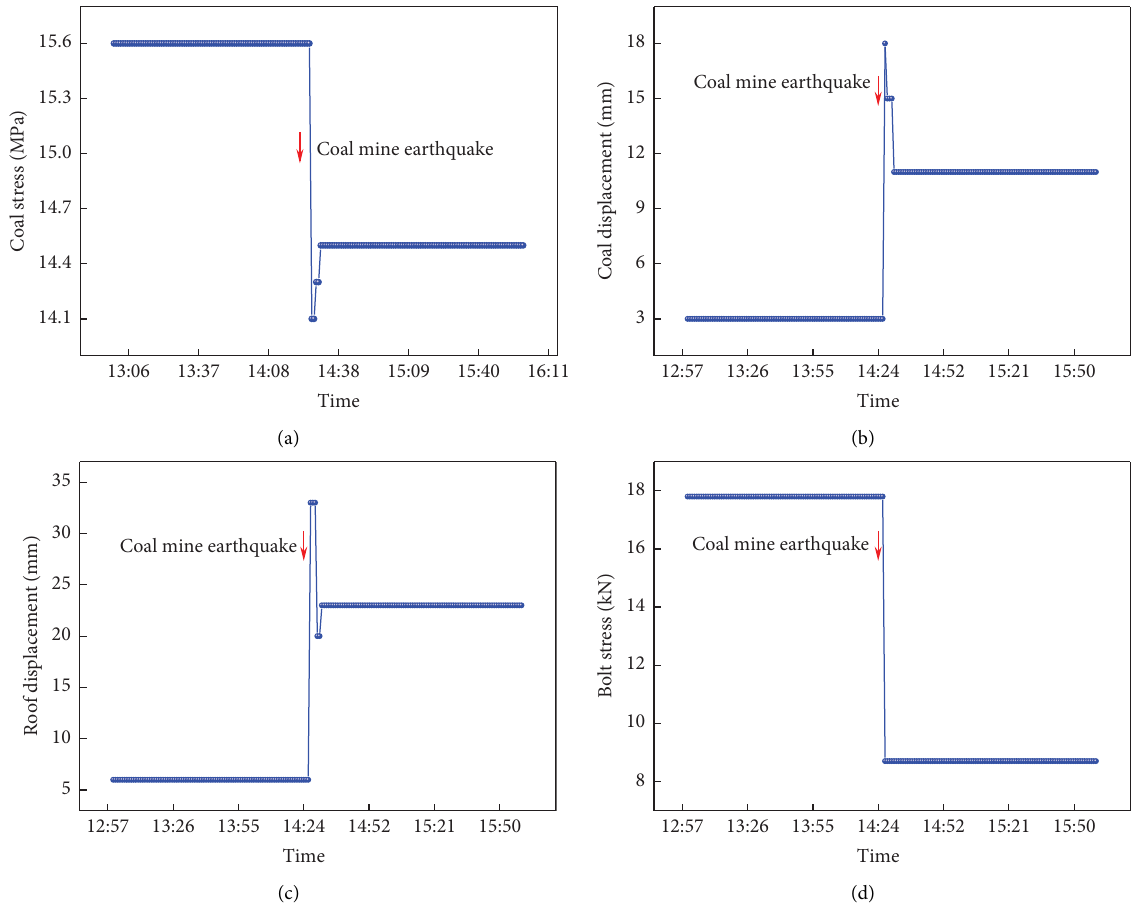
Figure 7: Parametric response curves during the coal mine earthquake. (a) Stress response curve of coal seam. (b) Displacement response curve of coal seam. (c) Roof displacement response curve. (d) Stress response curve of